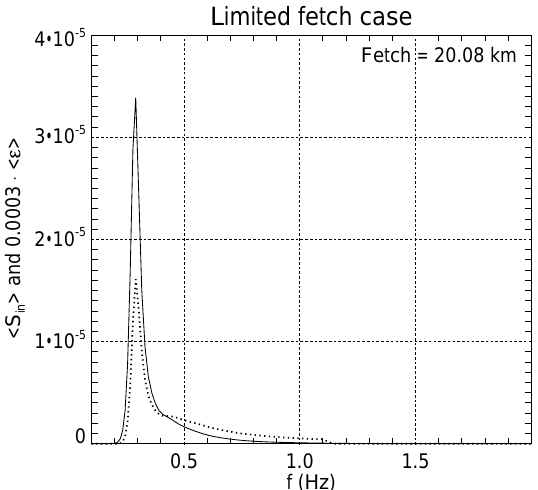
Figure 16. “Magic number” 10 q − 2 p as a function of dimen- sionless fetch xg/U 2 for the limited fetch case. Wind speed U = 10ms − 1 – solid line; wind speed U = 5ms − 1 – dashed line. Hori- zontal dashed line – self-similar target value 10 q − 2 p = 1.